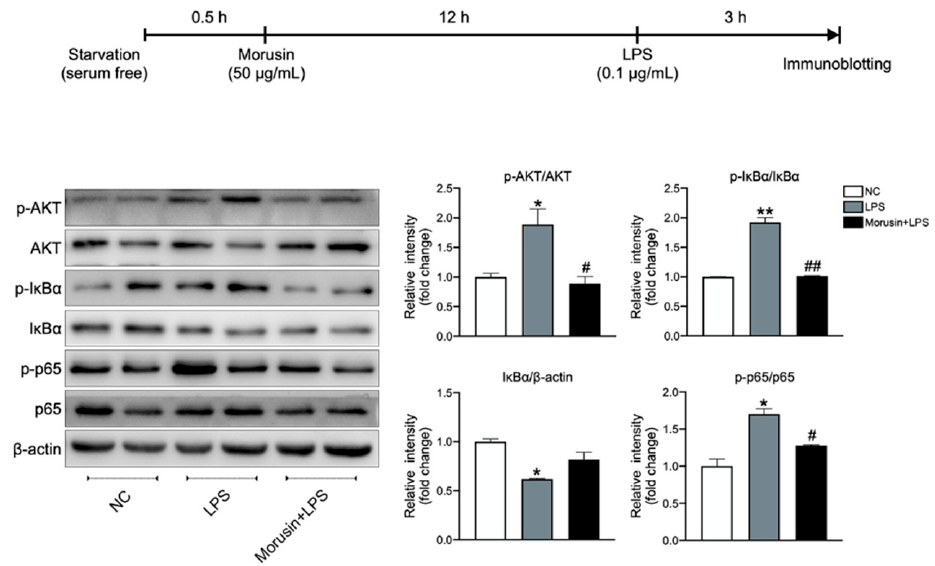
Figure 6. Protein expression level of p-AKT/AKT, p-I κ B α /I κ B α , I κ B α / β -actin, and p-p65/p65 in ruminal epithelial cells (RECs) among different treatments. β -actin was used as reference protein. RECs were treated without (NC, n = 4) or with 0.1 µg/mL lipopolysaccharide for 3 h after pretreating with 50 µg/mL of Morusin for 12 h (Morusin+LPS, n = 4) or not (LPS, n = 4). Data represent mean ± SEM. * p < 0.05, ** p < 0.01 vs. NC; # p < 0.05, ## p < 0.01 vs. LPS.